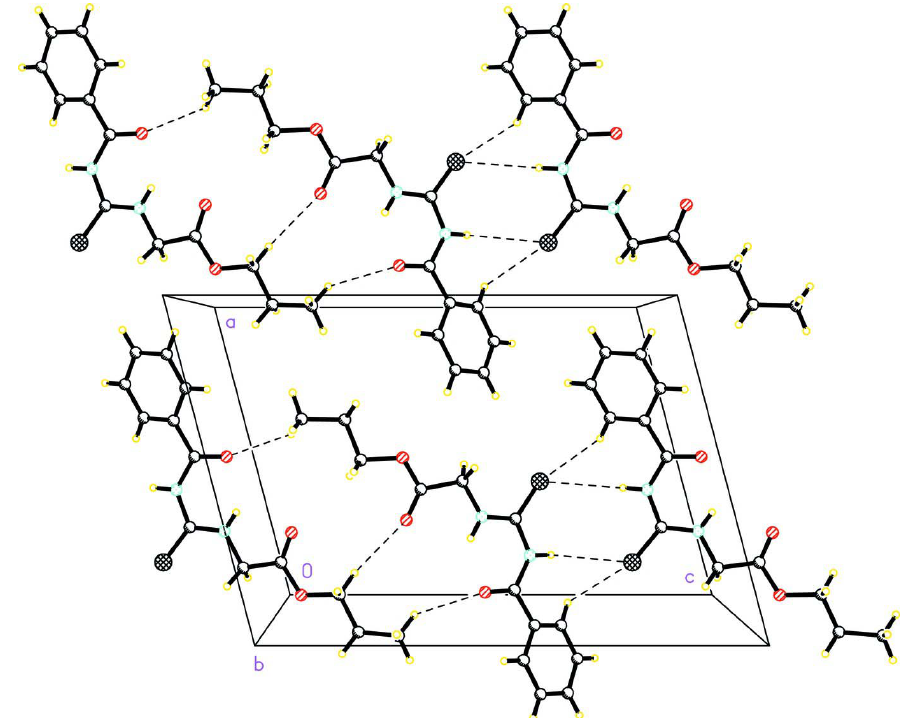
Figure 2 Crystal packing of (I) viewed down the a axis. Hydrogen bonds are drawn as dashed